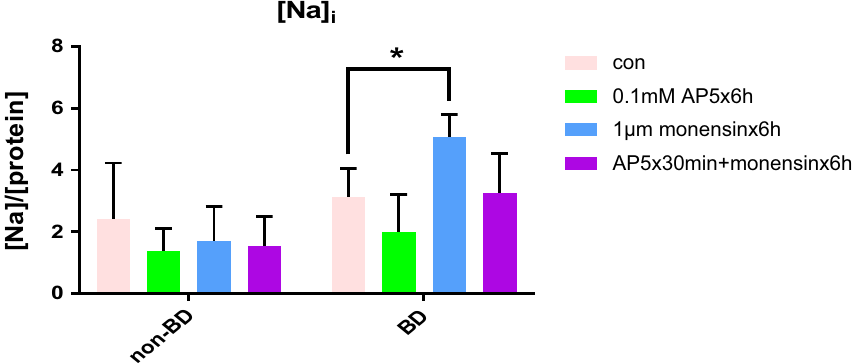
Figure 1. Intracellular sodium concentration with monensin treatment significantly increases only in ONPs from BD patients, but not non-bipolar controls, treated with monensin 1 µm for 6 h (* P < 0.05). BD ONPs pretreated by AP5 for 30 min followed by monensin for 6 h treatment were protected from the increase of intracellular sodium